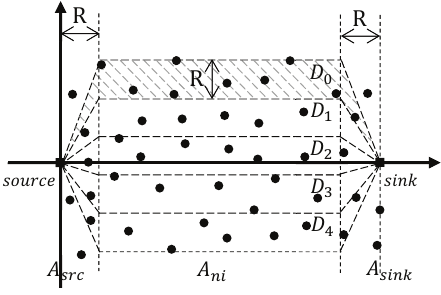
Figure 10. Division of Topology in